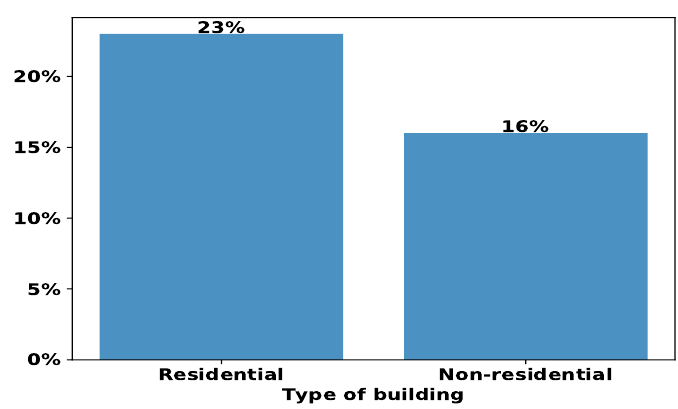
Figure 10. Controller application on comfort parameters.